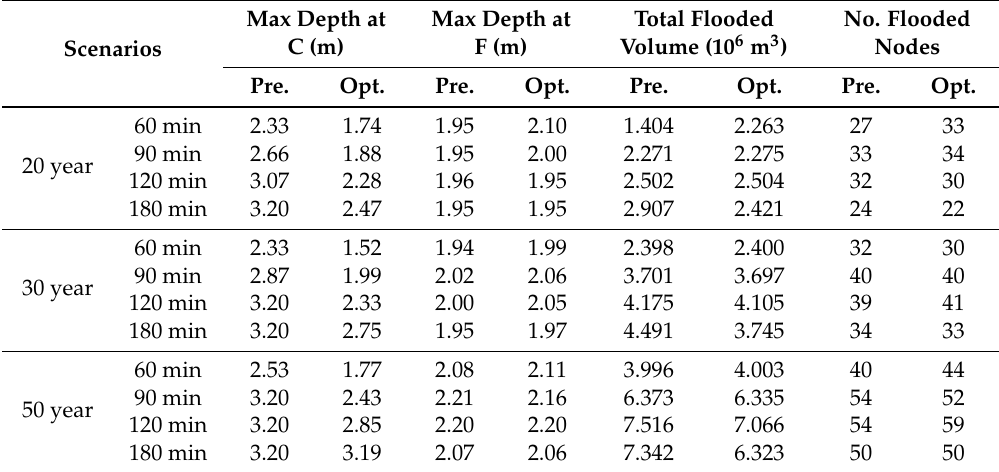
Table 6. Comparison of present and optimal detention reservoir facilities regarding flood damages in designed